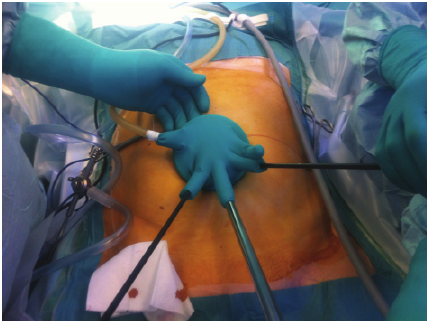
Figure 4: Placement of